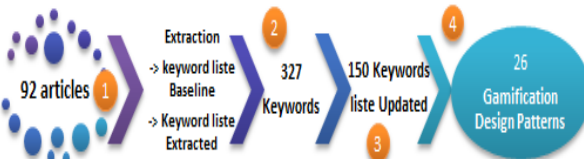
Figure 2 : extraction step of gamification design patterns